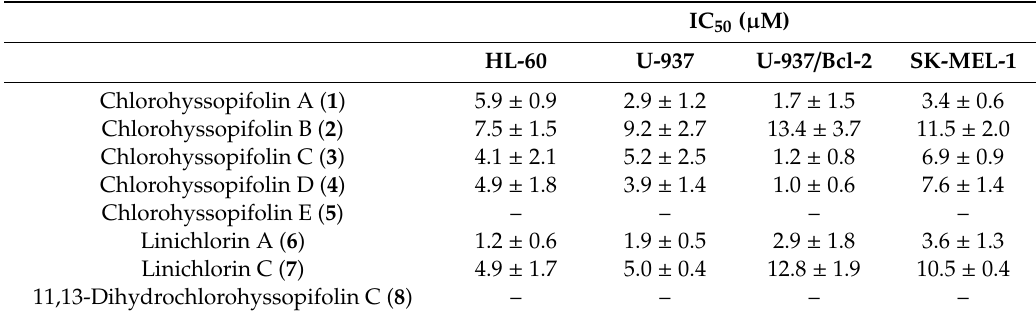
Table 1. E ff ects of guaianolides on cell viability of human tumor cell lines.